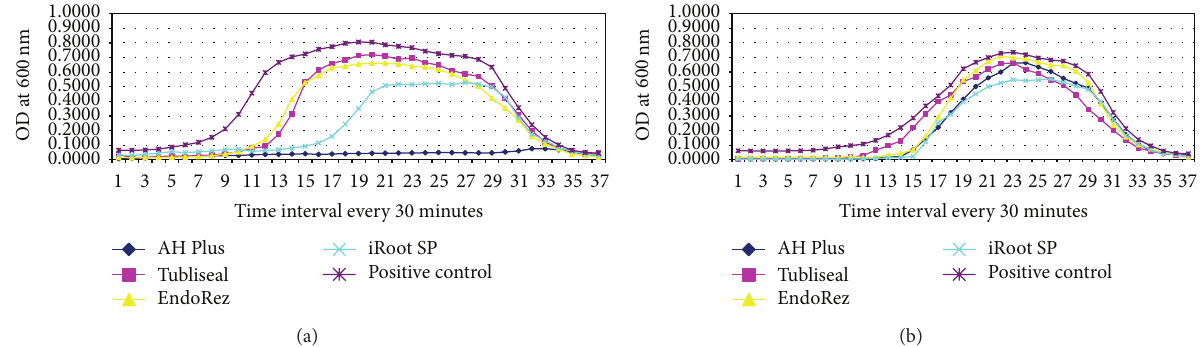
Figure 2: Line graph showing microbial growth curve of E. faecalis in (a) presence of tested sealers, A well and (b) absence of tested sealers, B well of the four different endodontic sealers. 𝑥 -axis depicts time intervals at which the mean OD was recorded (at every 30mins) and 𝑦 -axis depicts mean corrected OD recorded at 600 nm. Each point on the growth curve is the average of the OD measured in 12 wells.